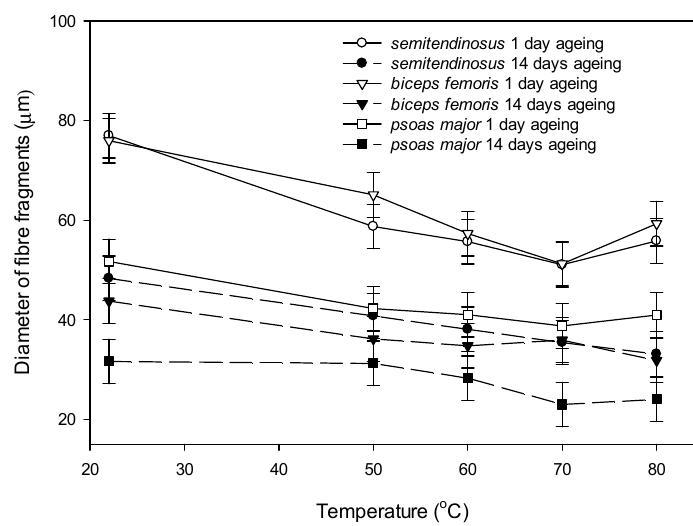
Figure 8. Effect of ageing (1 day post mortem vs. 14 days post mortem) and cooking temperature (raw, 50 °C, 60 °C, 70 °C and 80 °C) on diameter of fibre fragments obtained by homogenization of bovine raw and cooked semitendinosus , biceps femoris and psoas major . Cooking time was 30 min. after reaching the defined temperature (Tc + 30 min.). Values are least square means and vertical bars are least significant differences (LSDs) for the three-way interaction muscle × ageing × temperature. Main and interactive effects were as follows: p (muscle) < 0.001, p (ageing) < 0.001, p (temperature) < 0.001, p (muscle × ageing) < 0.001, p (muscle × temperature) < 0.001, p (ageing × temperature) < 0.001, p (muscle × ageing × temperature) = 0.011.